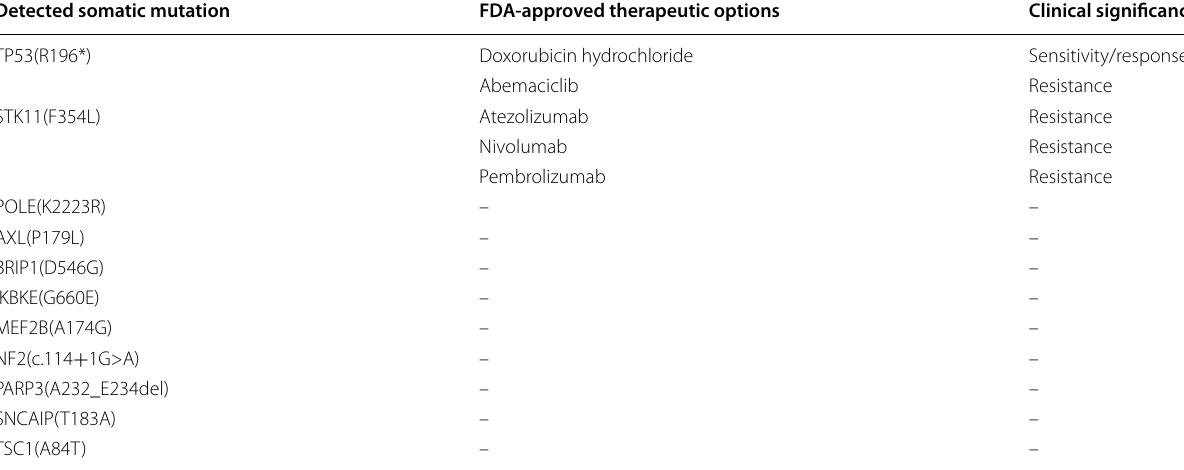
Table 1 Genomic analysis of undifferentiated embryonal sarcoma of the liver by FoundationOne CDx Detected somatic